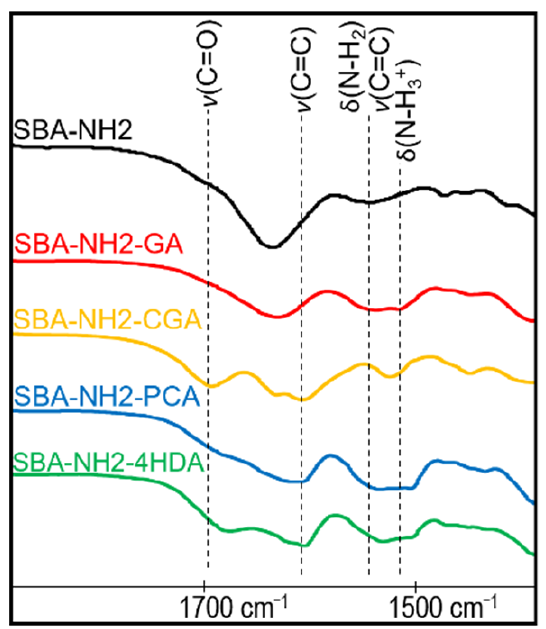
Figure A2. The FTIR spectra of parent SBA ‐ NH2 and antioxidant ‐ loaded SBA ‐ NH2 silica materials (types of vibration: υ —stretching; δ —bending).